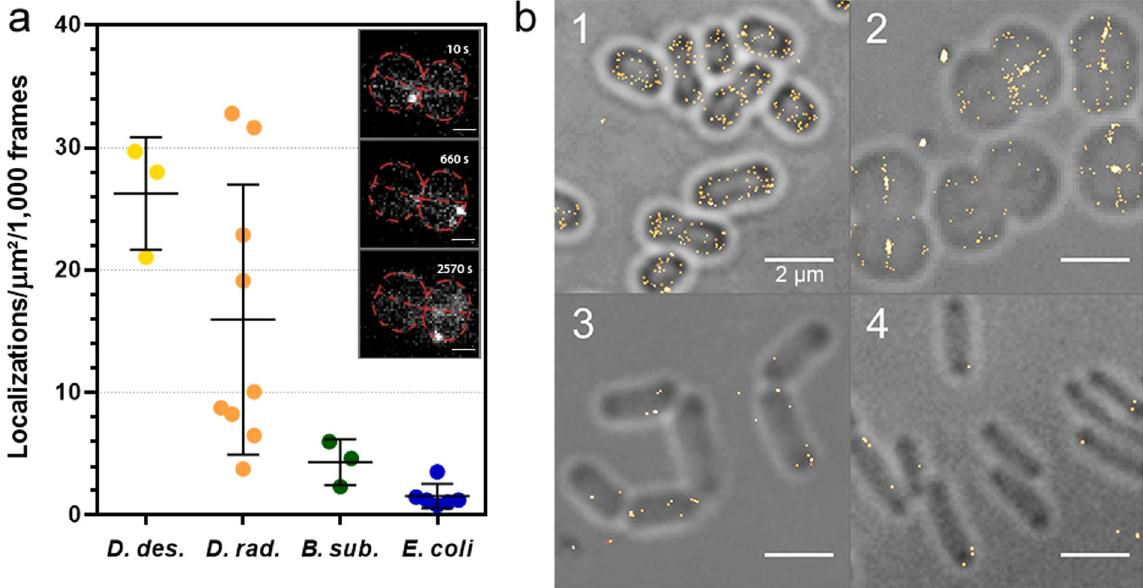
Figure 1. Autoblinking levels in D. deserti , D. radiodurans , B. subtilis and E. coli . ( a ) Number of localizations per μ m 2 per 1000 frames extracted from images acquired with 50 ms exposure under continuous 0.8 kW/ cm 2 561 nm laser. Individual data points correspond to the autoblinking levels derived from a given stack of images. Means and standard deviations are plotted in the graph. Inset: examples of raw autoblinking signal (bright white spots) observed in the cell periphery of a D. radiodurans tetrad (outlined in red and presented in Fig. 2) at different timepoints during image acquisition (see also Supplementary Movie S1). Scale bar: 1 μ m. ( b ) Representative reconstructions of live, unlabeled D. deserti (1), D. radiodurans (2), B. subtilis . (3) and E. coli (4) superimposed on their respective brightfield images. In each case, the reconstructed images are derived from